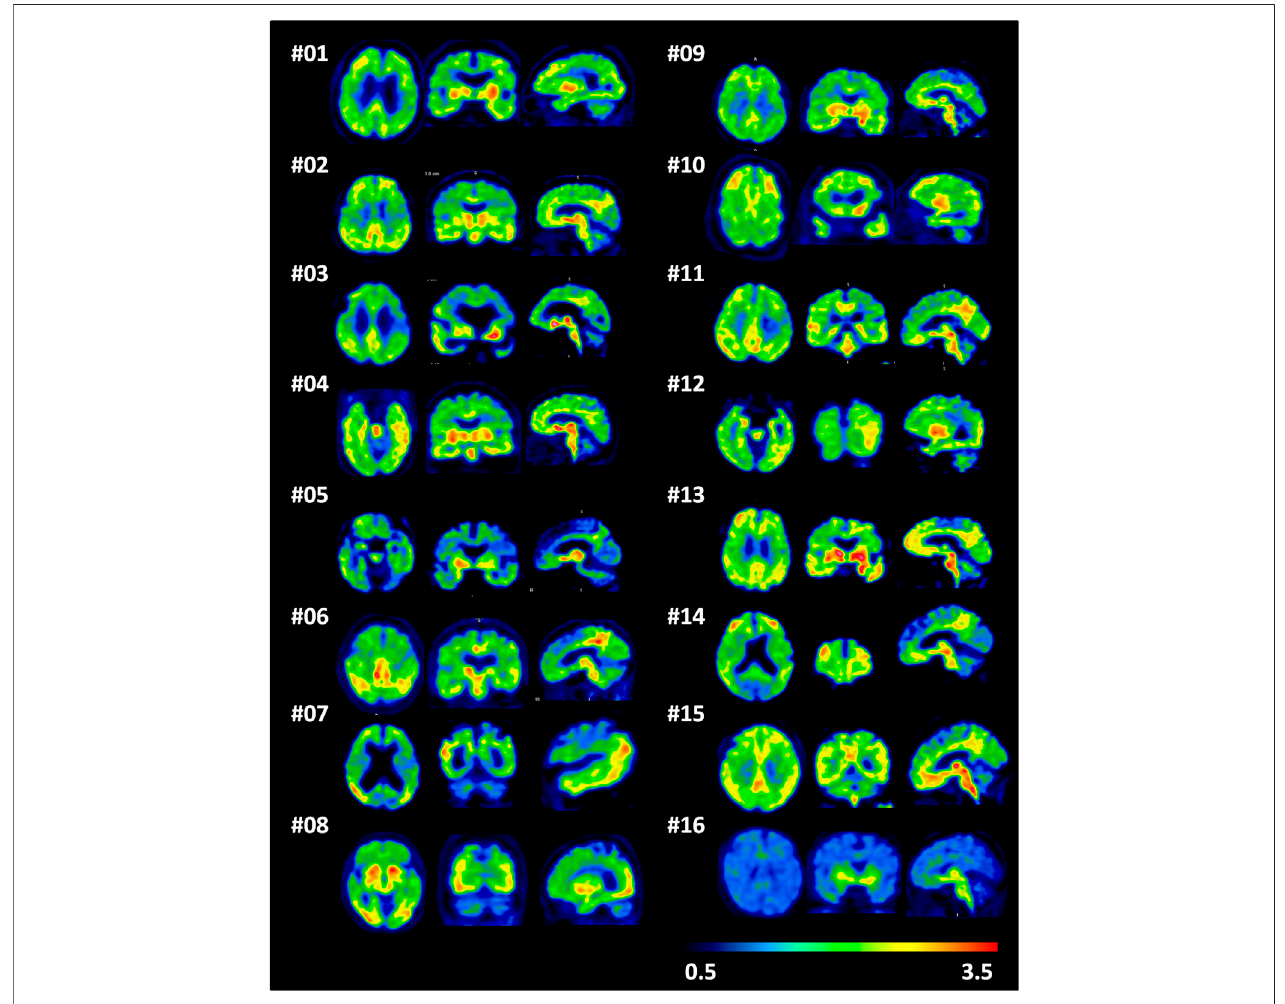
FIGURE 2 | A single frame of [ 18 F]-S16 positron emission tomography images (85 – 90 min) in a transverse, coronal, and sagittal plane for all Alzheimer ’ s disease patients (subjects 1 – 15) and one representative healthy control (subject 16).